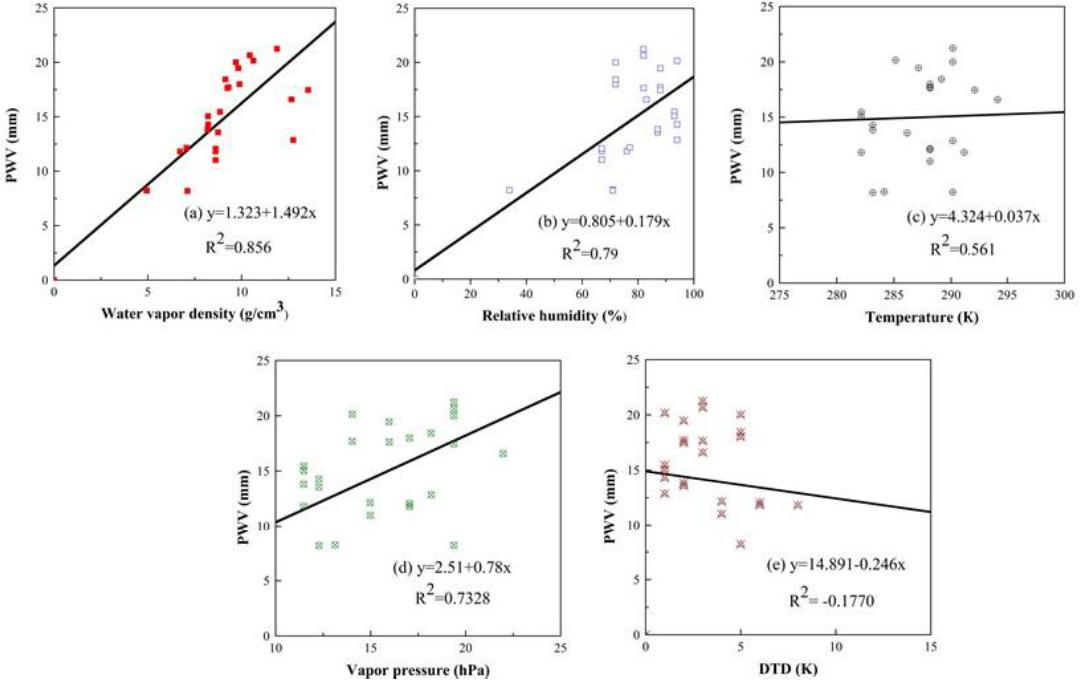
Figure 15. Correlation analysis between PWV and meterological parameters during the rainfall case.